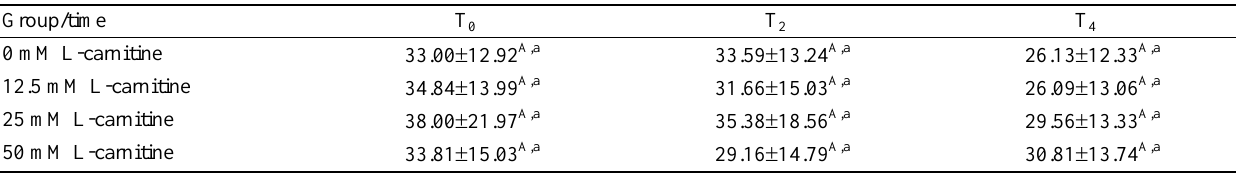
Table 5. Sperm acrosome integrity (%) of post-thawed cauda epididymal spermatozoa after thawing for 0 h (T0), 2 h (T2) and 4 h (T4) in each treatment and control (mean  SD) Group/time T 0